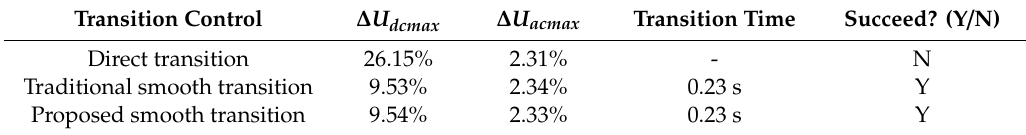
Table 2. Hybrid micro-grid operating status from islanding mode to grid-connected mode.